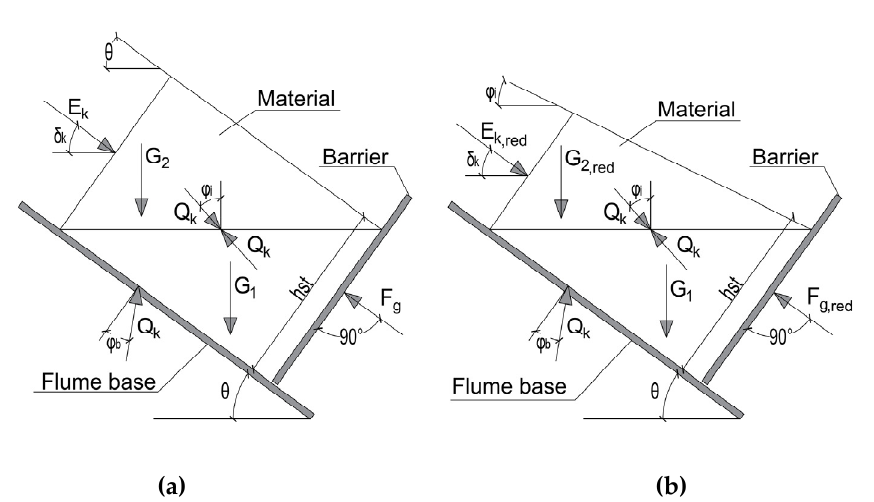
Figure 18. Force vectors for the determination of the creep pressure K g using the partial sliding bodies and taking into account the angle of the bottom friction: ( a ) surface inclination equal to 𝜃 , and ( b ) surface inclination equal to 𝜑 .